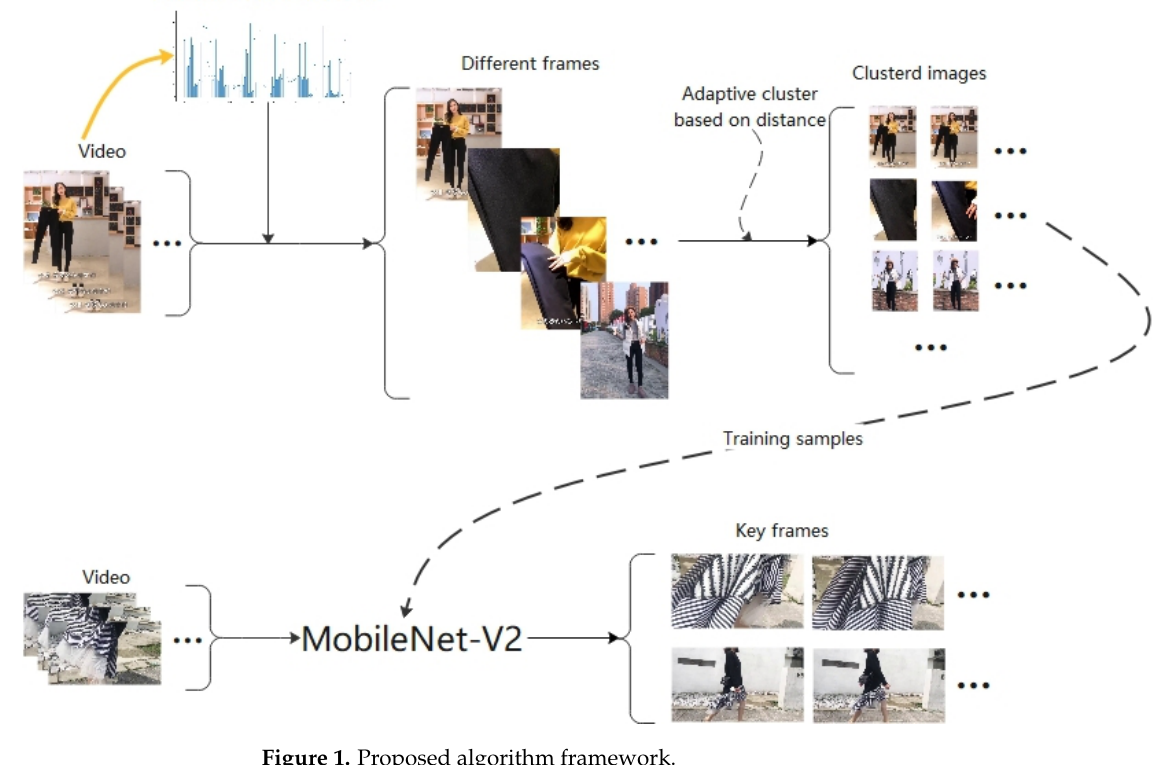
Figure 1. Proposed algorithm